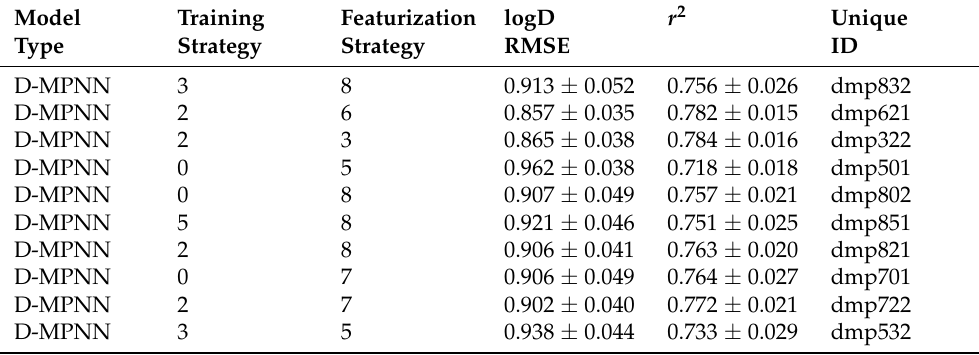
D-GIN cons. Table A13. Shows the logS RMSE and r 2 results for the D-MPNN model type used during this survey. The last column consist of the unique identify. Training strategy 0 represents a training strategy combining logD, logS, and logP, 1 represents a strategy combining logD and logP, 2 stands for a combination of logD and logS, 3 represents a strategy using logS and logP, 4 represents a strategy using logD, 5 represents a strategy using logS, and 6 represents a strategy using